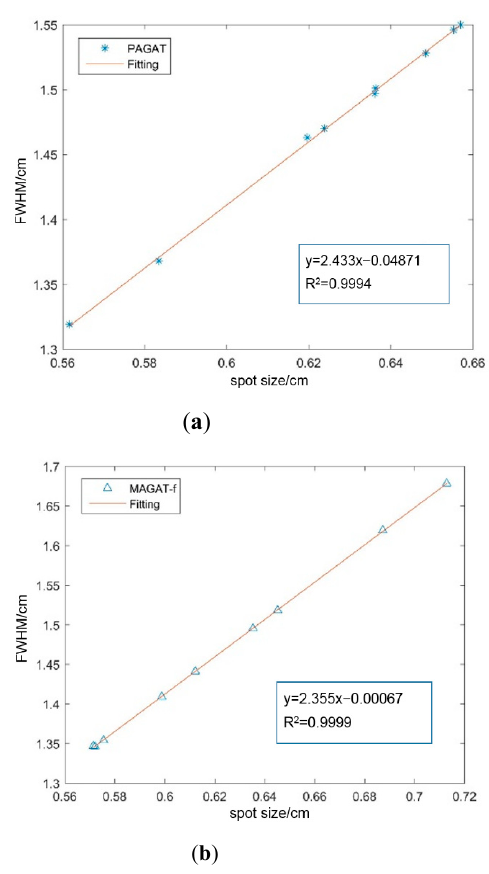
Figure 8. Correlation between FWHM and spot width measured with ( a ) PAGAT and ( b ) MAGAT-f gels.